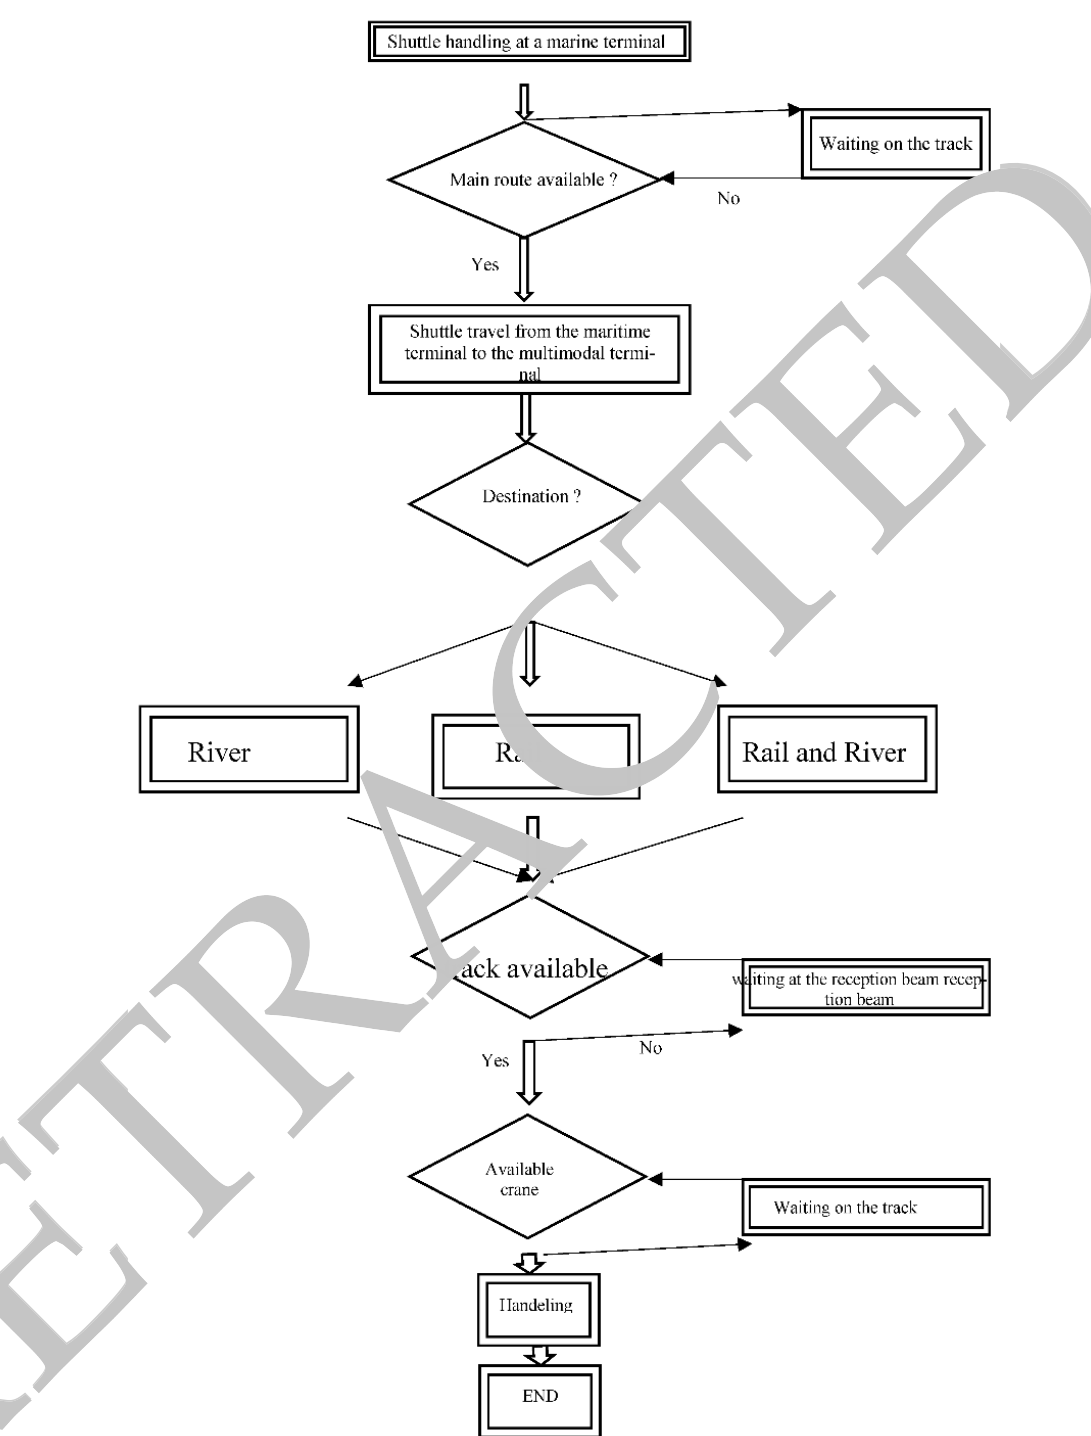
Figure 1. Container transfer process.